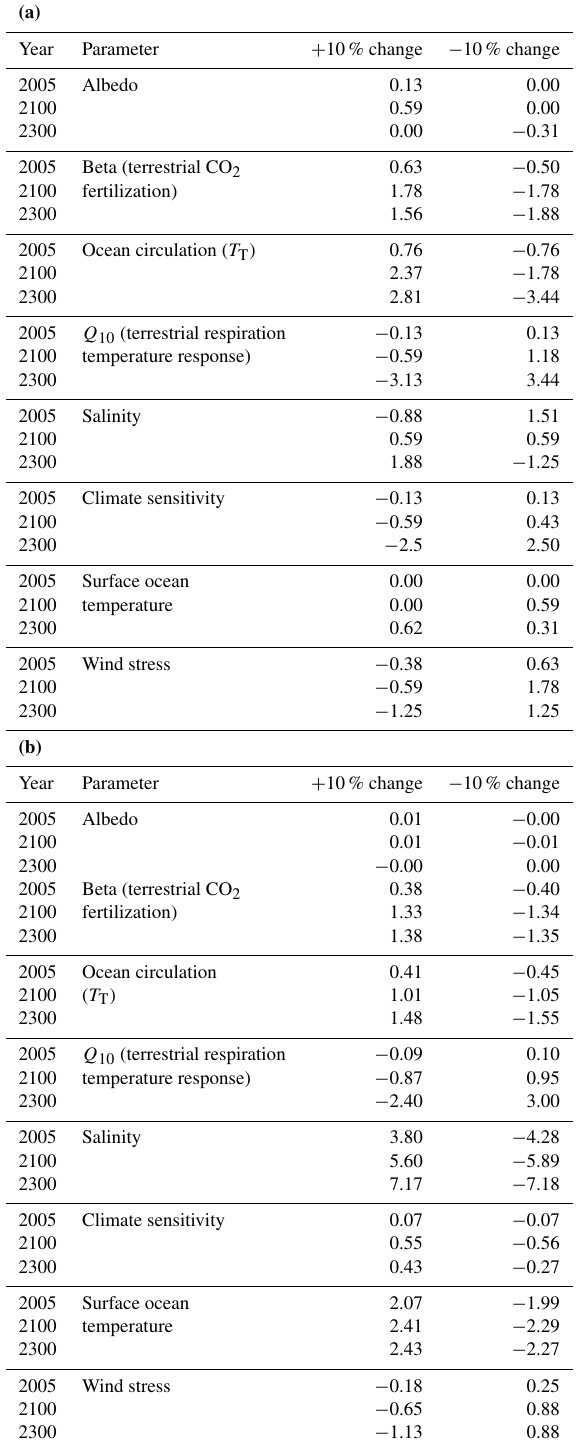
Table 7. Percentage change from reference (RCP 8.5) for two Hec- tor outputs, (a) global [H + ] and (b) global (cid:127) Ar , for a ± 10% change in eight model parameters. Results are shown for three years: 2005, 2100, and 2300.